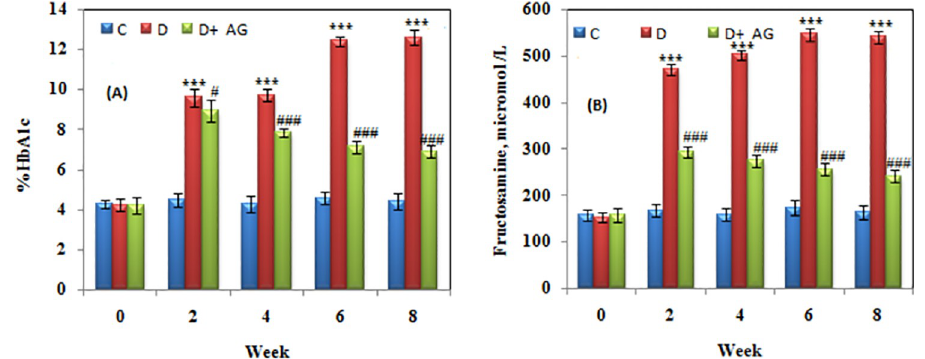
Fig 2. Early glycation markers (Amadori products) of alloxan-induced diabetic rabbits treated for 8 weeks with aminoguanidine. Panel ( A ) is % HbA 1c and Panel ( B ) is fructosamine. Values are mean ± SD, (n = 6 rabbits/group). ��� Significant difference (p < 0.0001) as compare to control. #,### Significant difference (p < 0.01, p < 0.0001) as compare to diabetic rats.